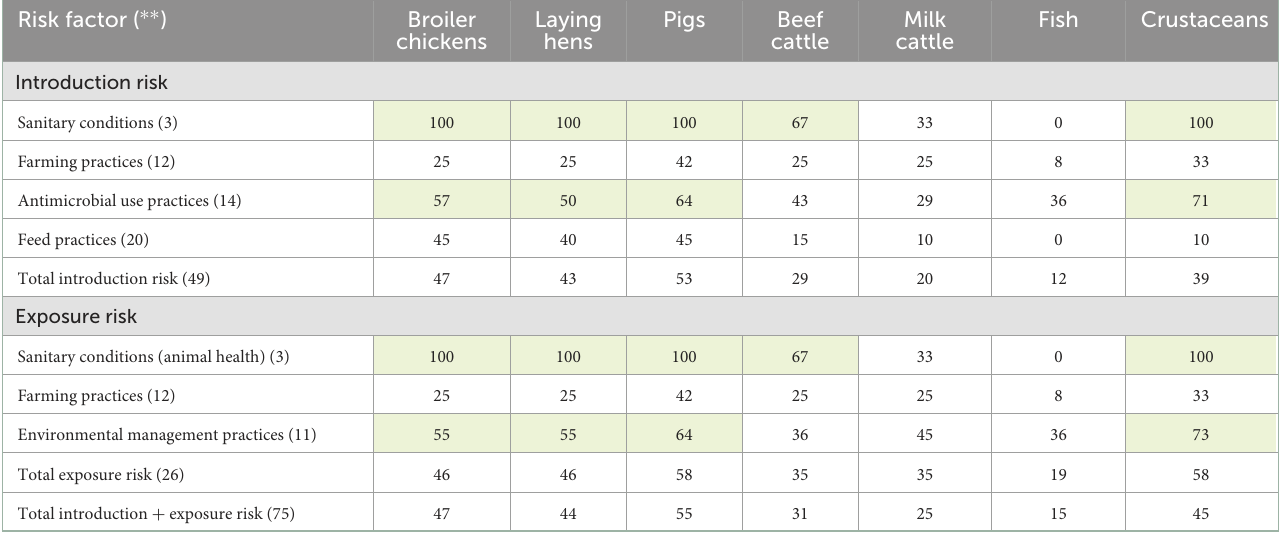
TABLE 8 Percentage of subfactors that present risks ∗ based on the qualitative risk assessment for animal health, by risk factor and animal production system.